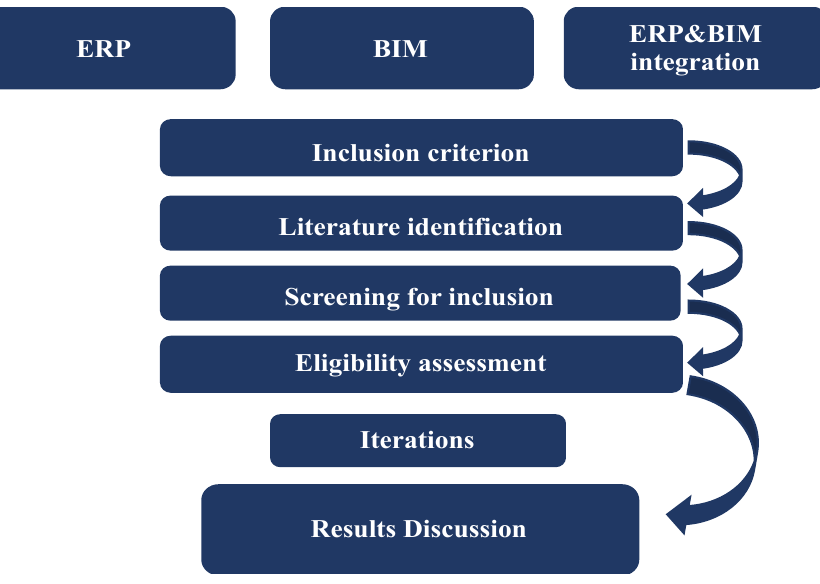
Figure 1. Organization of the methodology.